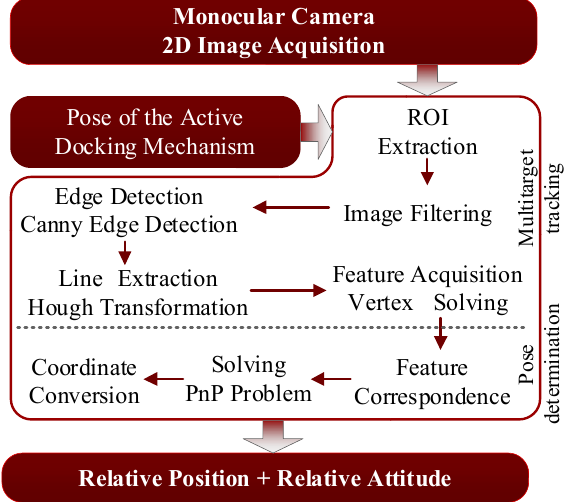
Figure 5. Algorithmic framework of the monocular vision system.